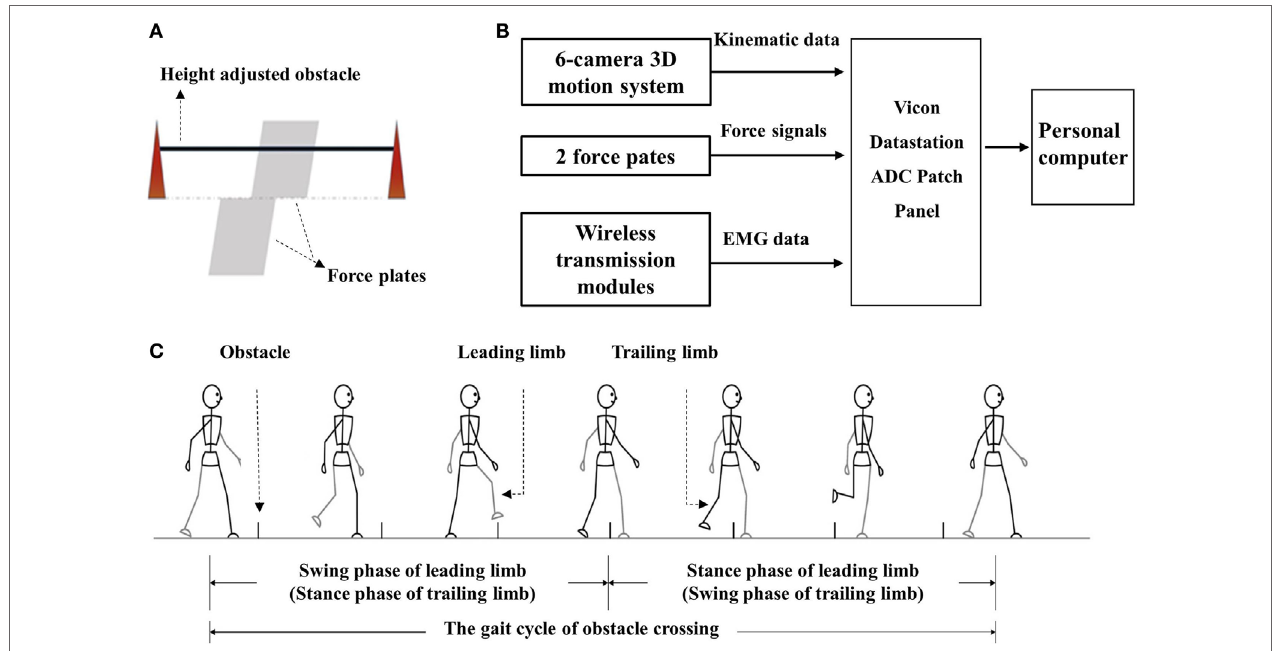
FigUre 1 | (a) The diagram of obstacle and force plate; (b) flow diagram of the procedure of data collection and storage; and (c) diagram of the gait cycle of obstacle